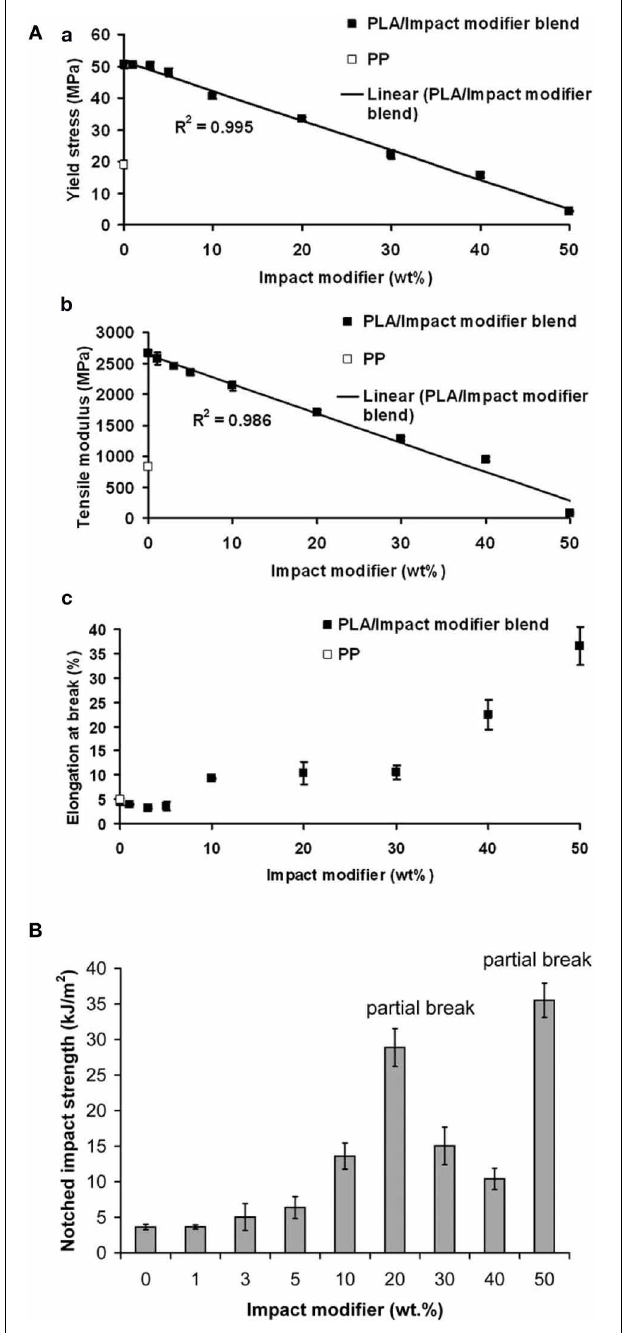
FIGURE 12 | (A) Tensile properties of PLA and PLA/impact modifier blends. (a) Yield stress; (b) tensile modulus; and (c) elongation at break. (B) Notched impact strength of PLA and PLA/ impact modifier blends. Notched impact strength for PP = 7.81 6 ± 1 . 50kJ/m 2 . Copyright (2011) Wiley; used with permission from Taib et al. (2012).